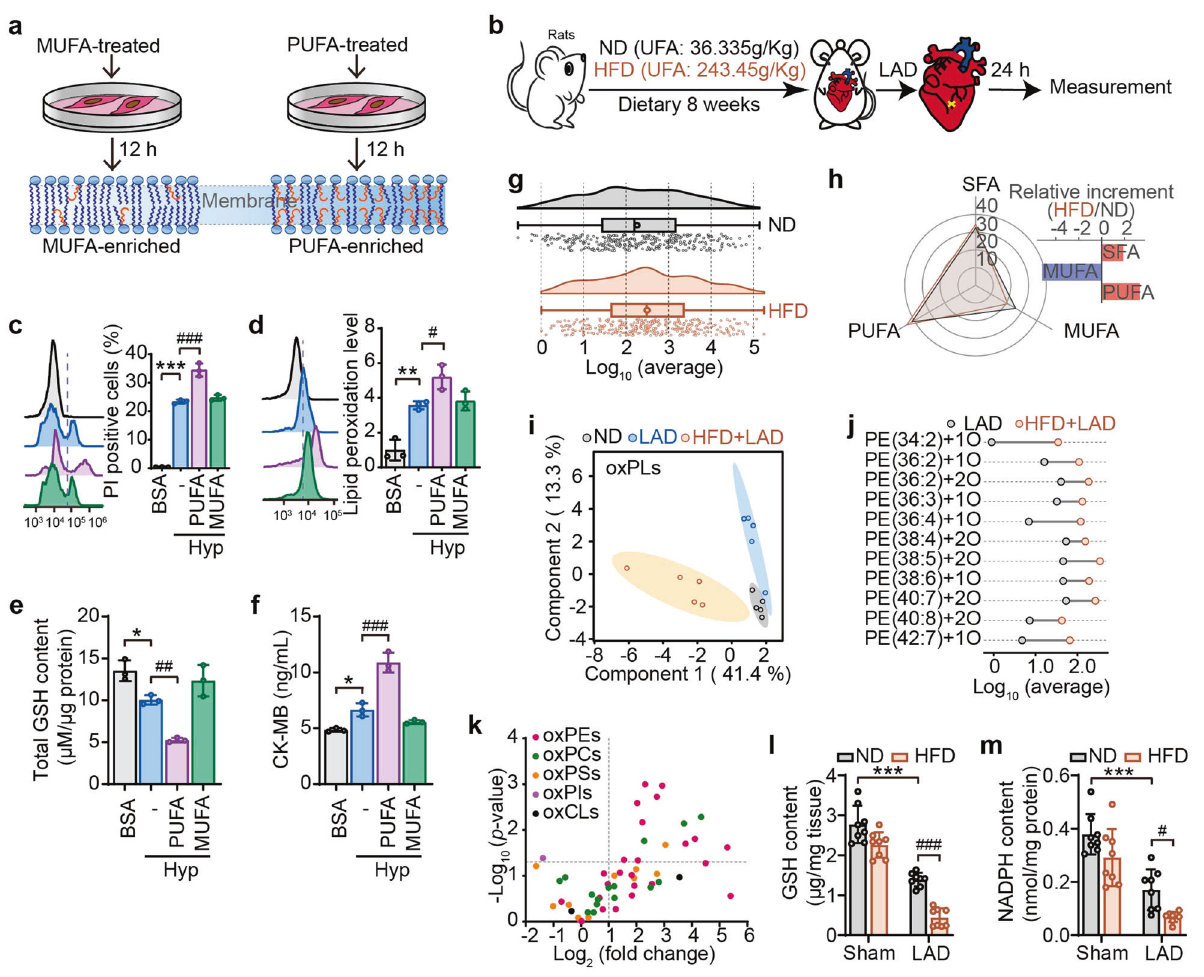
Fig. 2 Oxidized PUFA-PEs serve as crucial death signals for ischemia-induced myocardial damage. a Experimental schema for establishing MUFA or PUFA-enriched cells. H9C2 cells were treated with oleic acid (OA, 80 μ M) or linoleic acid (LA, 80 μ M) for 12 h. MUFA, monounsaturated fatty acids; UFA, unsaturated fatty acids. b Schematic depicting the establishment of ischemia animal model in rats fed with normal diet (ND, containing 36.335 g/kg of UFA) or high-fat diet (HFD, containing 243.45 g/kg of UFA). After 8 weeks-feeding, rats were subjected to ischemia by left anterior descending (LAD) coronary artery ligation. After inducing hypoxia in cells treated with BSA-prepared PUFA or MUFA, cell death ( c ) and lipid peroxidation ( d ) were, respectively, evaluated with PI and Liper fl uo staining followed by fl ow cytometry. BSA treatment was set as the control group. Total content of GSH ( e ) or CK-MB ( f ) in PUFA/MUFA-enriched cells at 4-h hypoxia treatment. g The raincloud plot shows the content of Log10 (average) changes in total PUFAs in the heart of ND-fed and HFD-fed rats ( n = 5). h Radar chart indicates the changes of SFA, MUFA, and PUFA in the heart of ND-fed and HFD-fed rats. The relative increment of these fatty acids was represented by a bar chart ( n = 5). i OxPLs were extracted and interpreted by principal component analysis (PCA), and the 2D score plots display repertoires of ND-sham, ND- LAD, and HFD-LAD rats. Each point represents a sample, and ellipses represent 95% con fi dence regions ( n = 5). j Dumbbell chart shows different types of oxPEs in the content of Log10 (average) changes among LAD-ligated rats fed with ND or HFD ( n = 5). k Volcano plots showing changes in oxPLs in heart tissue of LAD ligated rats with ND-and HFD-fed ( n = 5). The signi fi cance of -log10 ( P value) by t test. Content of GSH ( l ) and NADPH ( m ) were detected in ND or HFD-fed rats after 24-h LAD ligation. All the quantitative data are presented as mean ± SD and statistical signi fi cance was assessed by one-way ANOVA followed by Tukey post-hoc test. For the in vitro experiments, * p < 0.05, ** p < 0.01, *** p < 0.001 vs BSA control group; # p < 0.05, ## p < 0.01, ### p < 0.001 vs hypoxia (Hyp) group. For the in vivo experiments, *** p < 0.001 vs “ ND + sham ” group, # p < 0.05, ### p < 0.001 vs “ ND + LAD ”